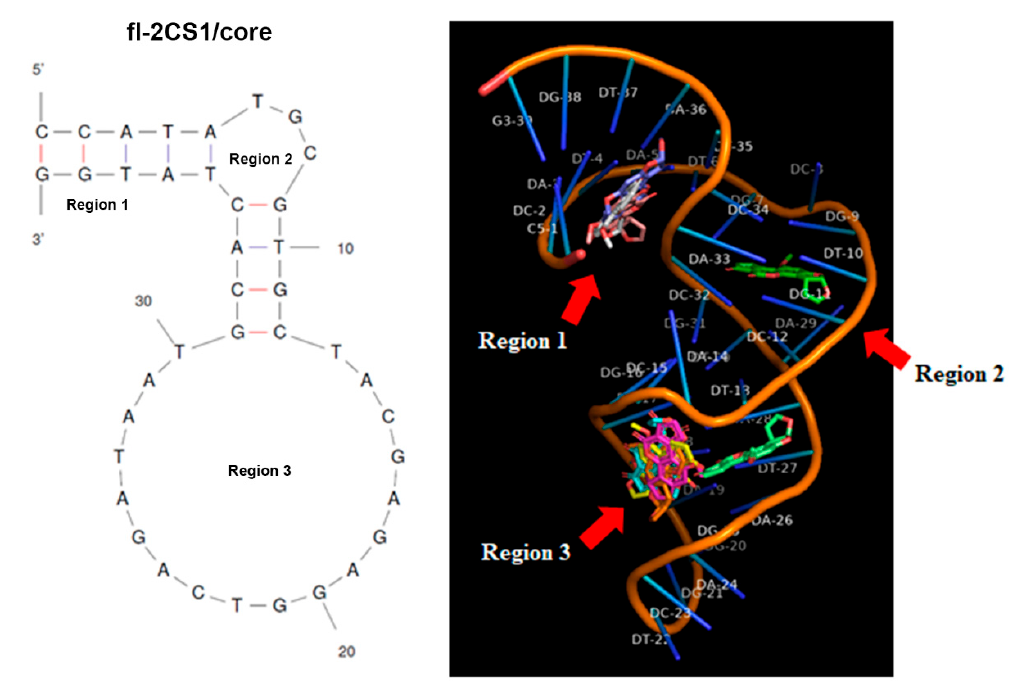
Figure 5. 3D structural model of fl − 2CS1/core and its possible docking sites with AFB1.